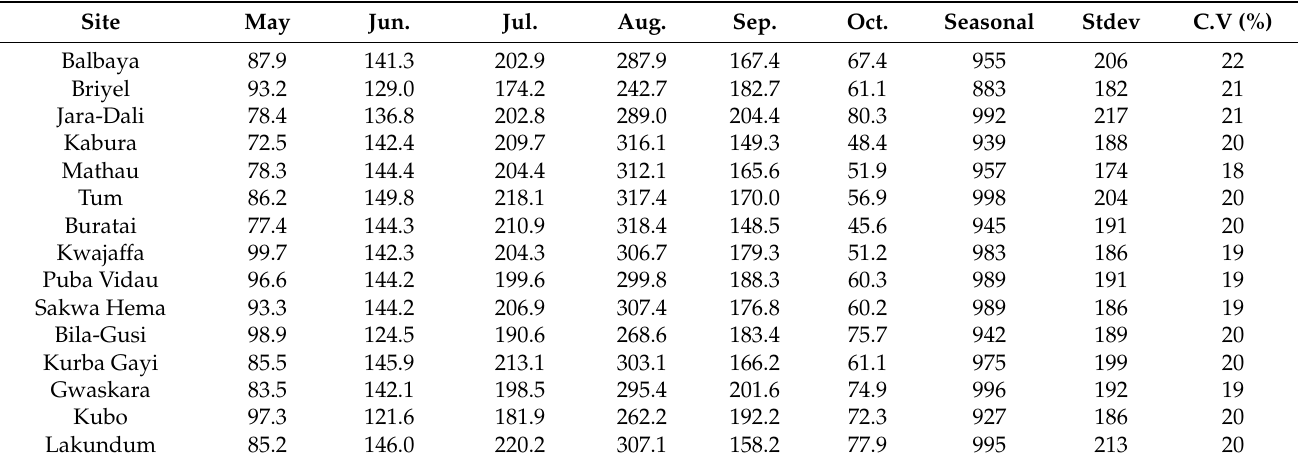
Table 8. Analysis of mean monthly, seasonal rainfall (mm) and level of variability across the simula- tion sites in Borno State from 1985 to 2010.